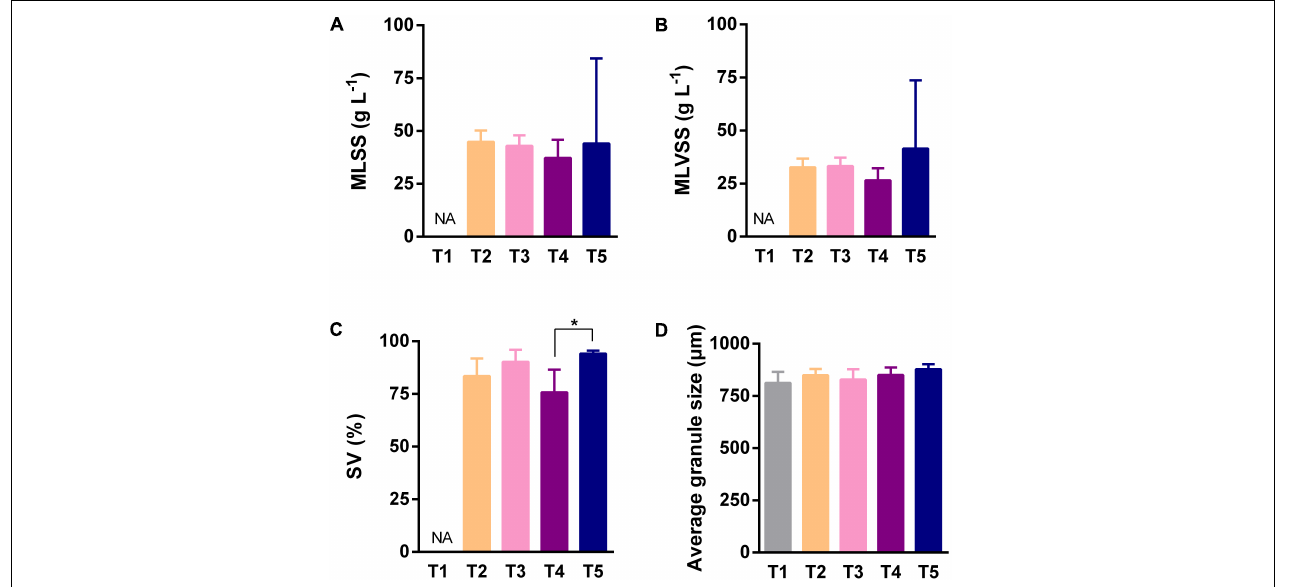
FIGURE 2 | Characteristics of anaerobic granular sludge (AGS) of different sampling time points. (A) The mixed liquid suspended solids of sludge. (B) The mixed liquor volatile suspended solids of sludge (biomass). (C) The percentage of sludge volume. (D) The average diameter of granule. Error bar was SD obtained based on the data of five sampling time points, ANOVA analysis of Kruskal–Wallis test was used to analyze variation between different sampling heights, ∗ P < 0.05. NA indicated no analysis.